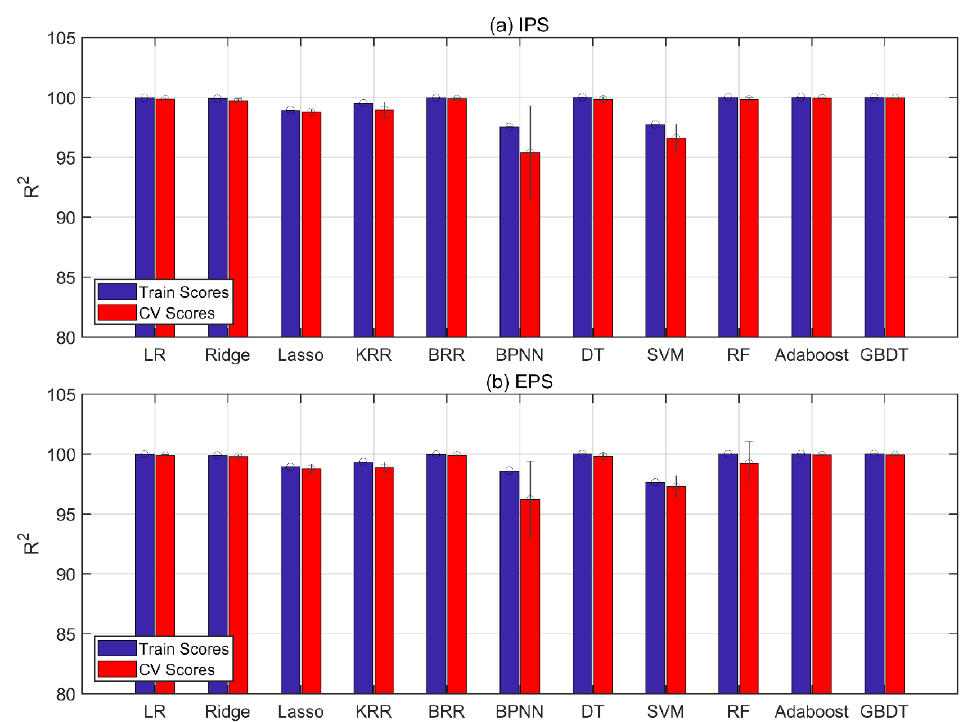
Figure 2. The R 2 scores of the considered models.